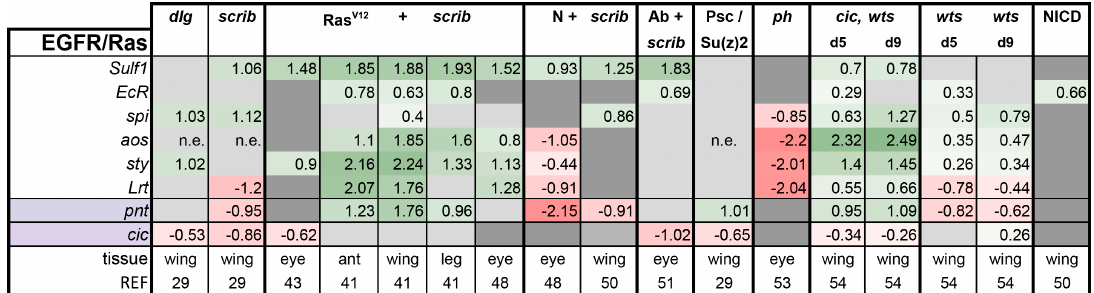
Figure 1. Expression levels of dilp8 and cell fate determinants in various tumor models. Samples were grouped according to their tissue of origin. Genes that act in the retinal determination network and their downstream effectors are highlighted in yellow, whereas genes required for cell fate determination in the wing are highlighted in blue. Three genes with developmental roles in both tissues are highlighted in green. Gene expression is displayed as fold change in log2 (log2FC) compared with controls. Color coding corresponds to a heatmap with a scale from -5 (dark red, downregulation) to 5 (dark green, upregulation). The midpoint, 0, is white. Light grey cells represent non-significant changes with p > 0.05. Cells are shown in dark grey if the gene was not found in the datasets owing to different cut-offs used by different groups. Abbreviations: Insulin like peptide 8, Ilp8; twin of eyeless, toy; eyeless, ey; eyes absent, eya; sine oculis, so; dachshund, dac; Embryonic Lethal Abnormal Vision, ELAV; atonal, ato; homothorax, hth ; teashirt.tsh; senseless, sens; Distalless, Dll; vestigial, vg; nubbin, nub ). 3.2. Inactivation of Hippo, Dpp, Hh, Wg, and Activation of JNK, JAK/STAT, and Notch Are Commonly